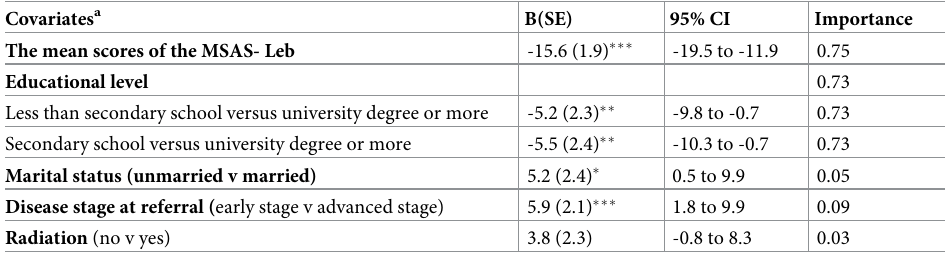
Table 5. Multiple linear regression of factors associated with